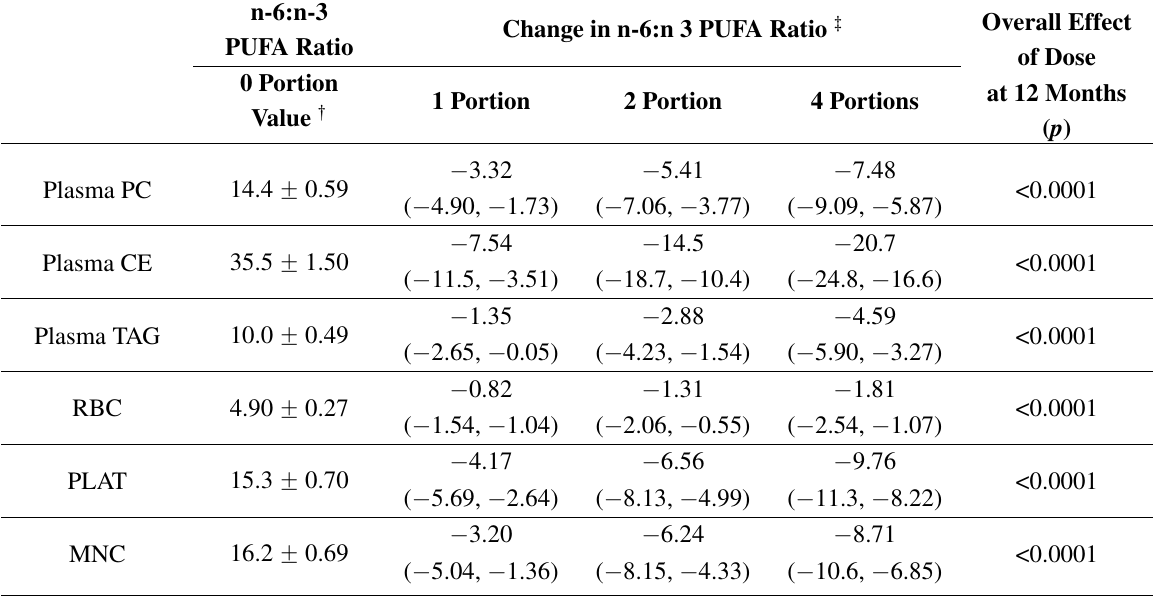
Table 2. The n-6:n-3 PUFA ratio in the 0 portions group and differences by dose in the change in the ratio after 12 months of EPA + DHA